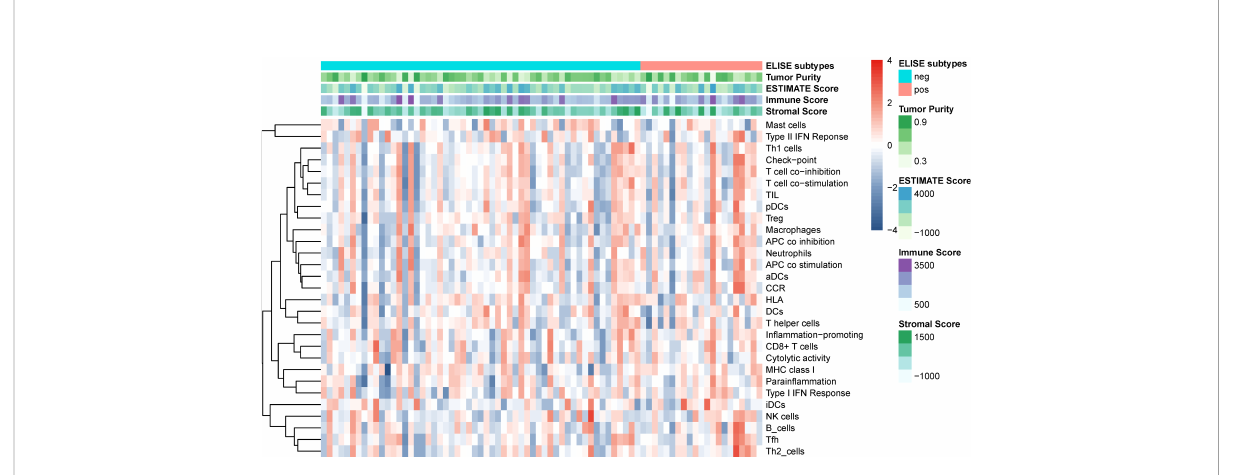
FIGURE 5 Tumor microenvironments and immune cell in fi